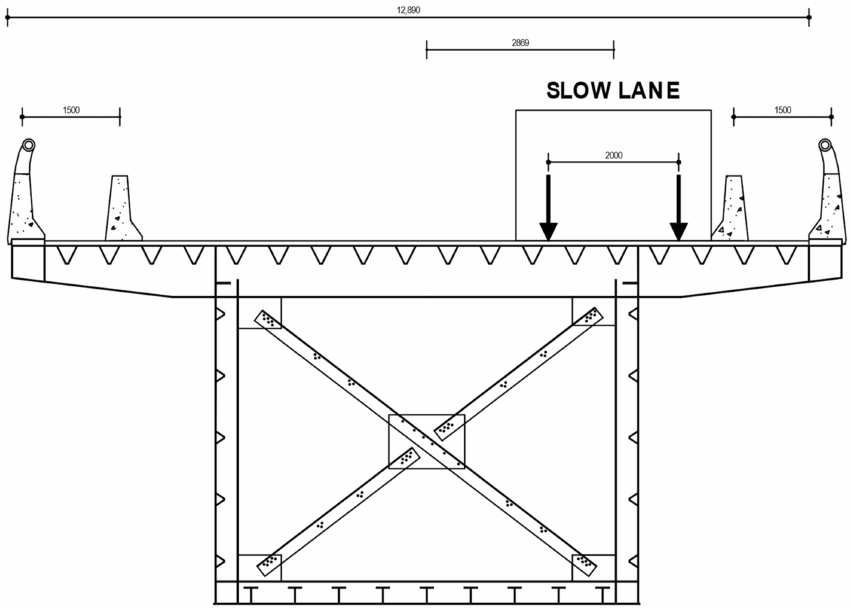
Figure 31. Slow lane position from around 2019, following the positioning of additional New Jersey barriers.